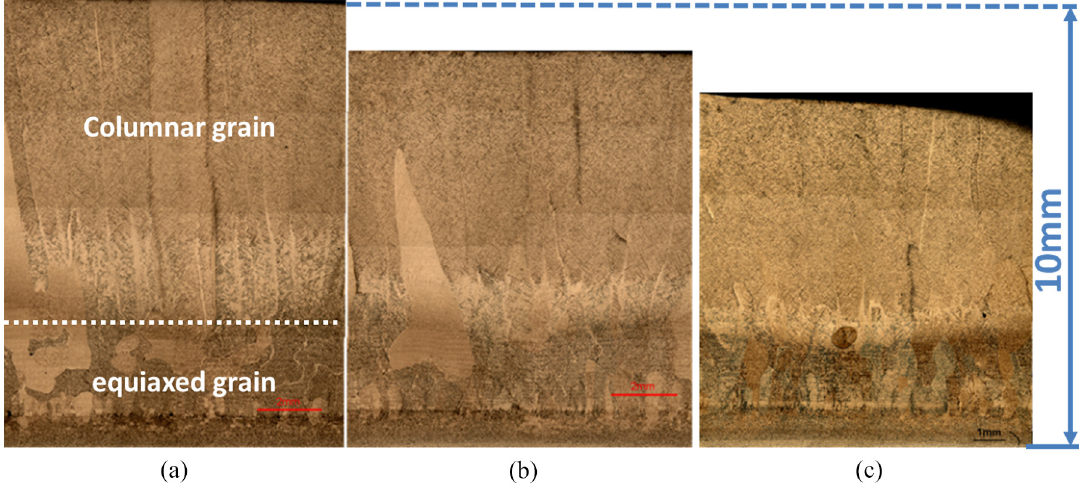
Figure 2. Montage of macrostructure of pulse laser deposition Ti6Al4V thin wall showing large columnar growth prior β grains with laser power of 923 W (a); 1230 W (b); 1538 W (c). (Frequency is 500 HZ, scanning speed is 800 mm/min, and average laser power is 600 W (a); 800 W (b); 1000 W (c)).